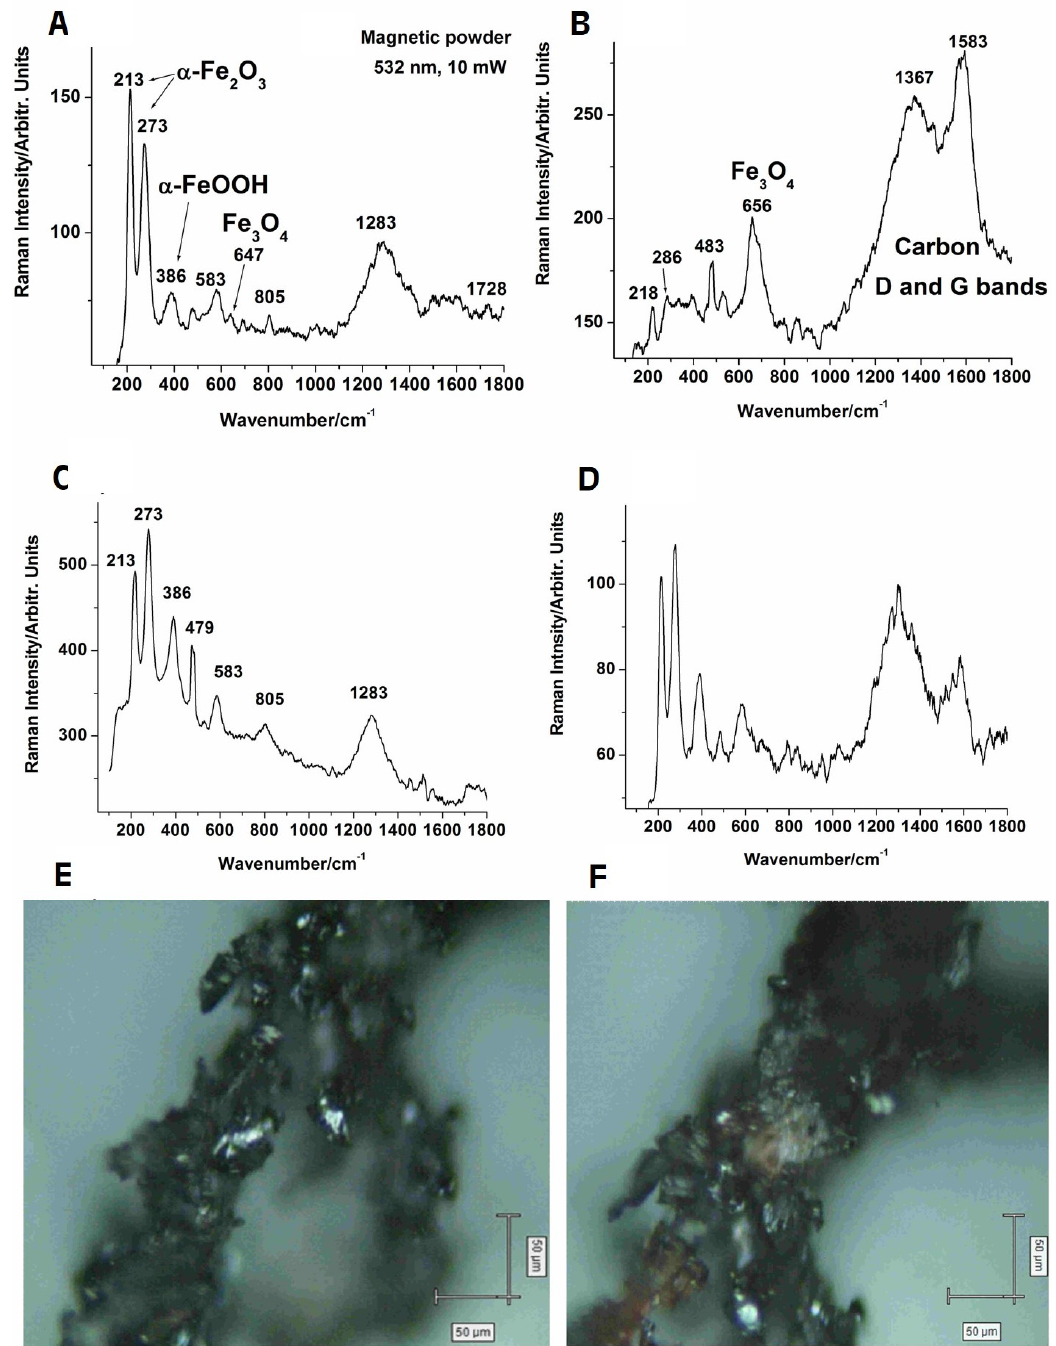
Figure 2. Typical Raman signal collected from different regions of the Fe 3 O 4 @Carbon nanoparticle powder samples ( A – D ) under 532 nm excitation (laser spot size ~720 nm); micrographs of the same sample region before ( E ) and after ( F ) laser exposure for spectra collection (20× objective).